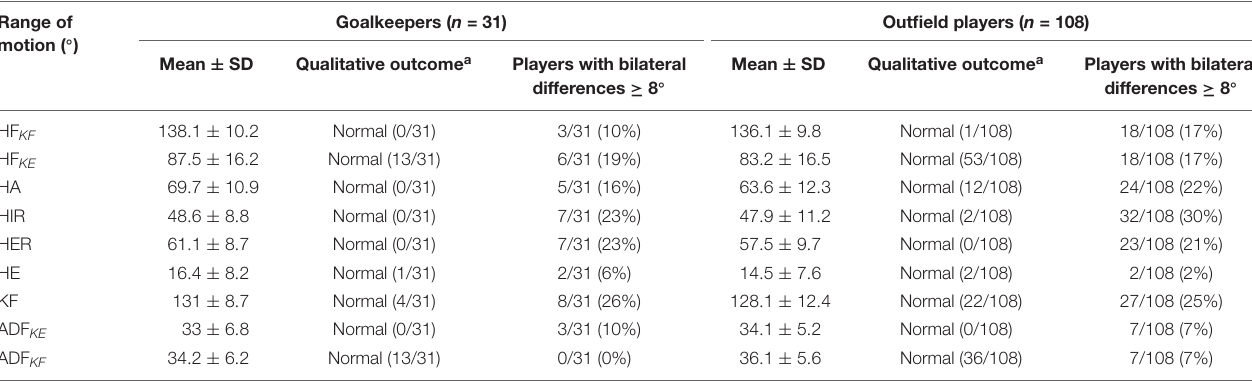
TABLE 3 | Descriptive values and number (percentage) of players with bilateral differences ≥ 8 ◦ for hip (flexion, extension, abduction, internal and external rotation), knee (flexion), and ankle (dorsal-flexion with knee flexed and extended) ranges of motion separately by player position. Range of Goalkeepers ( n = 31) Outfield players ( n = 108) motion ( ◦ ) Mean ± SD Qualitative outcome a Players with bilateral Mean ± SD Qualitative outcome a Players with bilateral differences ≥ 8 ◦ differences ≥ 8 ◦